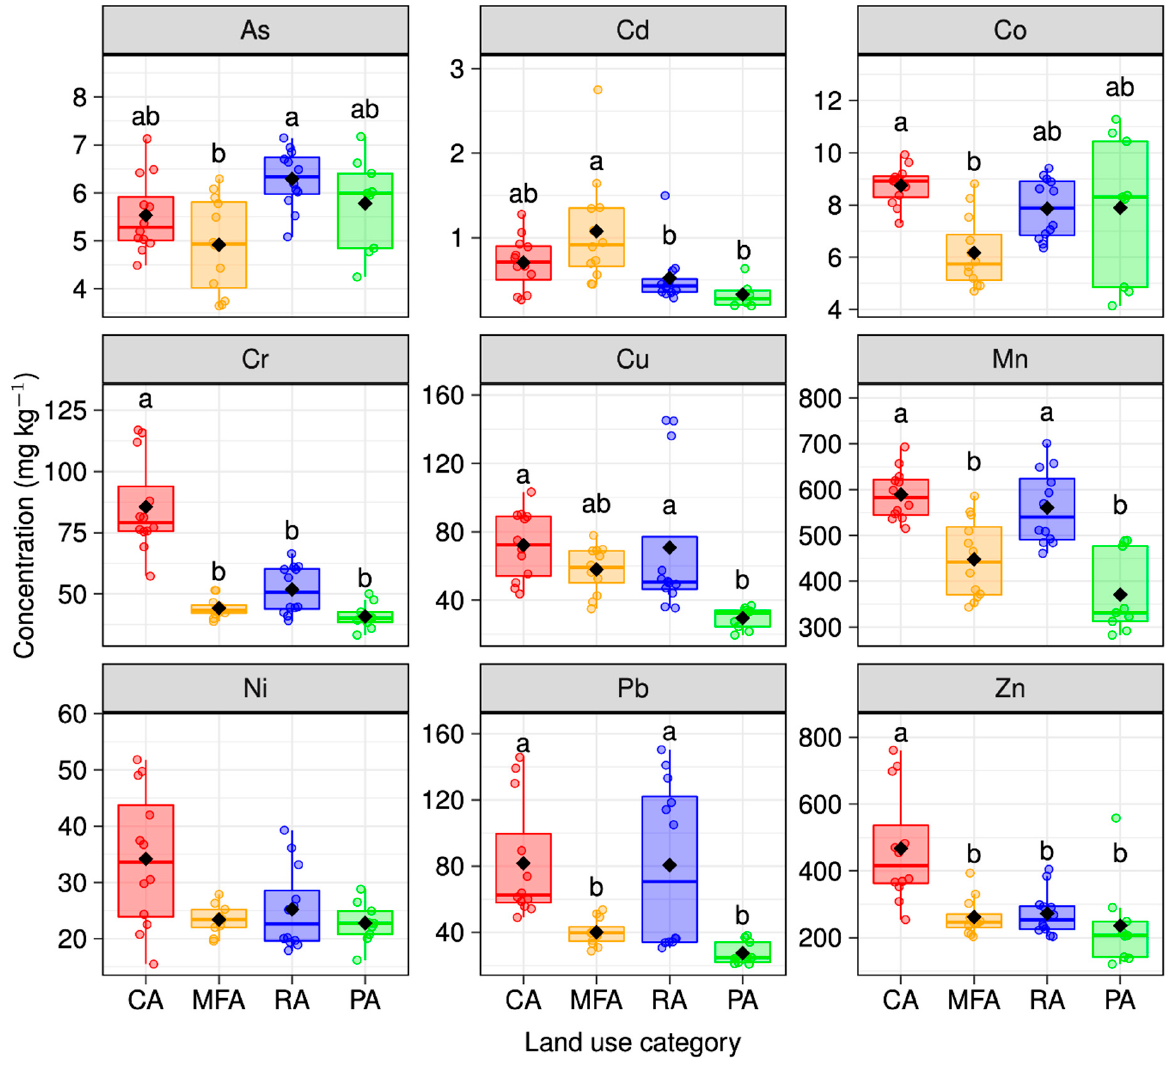
Figure 2. Total concentrations of toxic metals (As, Cd, Co, Cr, Cu, Mn, Ni, Pb, and Zn) with standard error in the road dust of Mymensingh City. Individual sampling points are represented by circles. CA = commercial areas, MFA = medically facilitated areas, RA = residential areas, and PA = park areas. At a probability level of 95%, bars with identical letters are not statistically significant at the 95% level of probability.